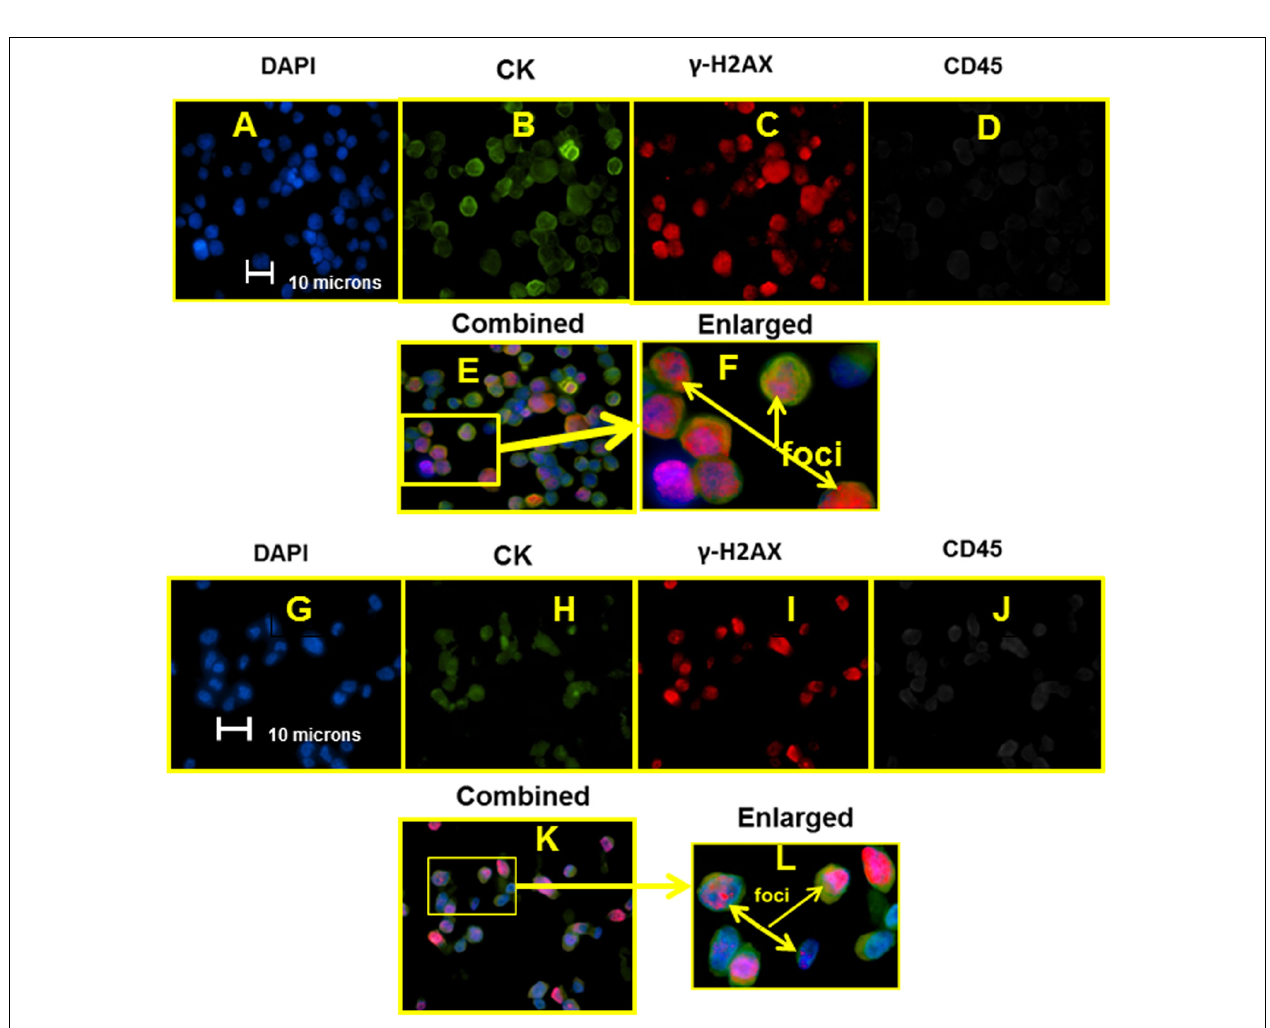
FIGURE 2 | Sets of epifluorescent images (A–F) for MCF-7 and (G–L) for MDA-MB-231. For (A–F) and (G–K) , images are the same location, different filter settings corresponding to the stained marker/structure targeted and listed above the image. Figures (F) and (L) are the enlargements highlighted (E) and (K) ,